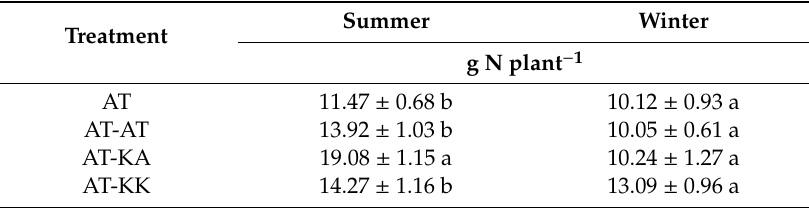
Table 4. Nitrogen uptake per plant during the summer or winter season. Di ff erent letters in the same column denote significant di ff erences ( p < 0.05) between grafting